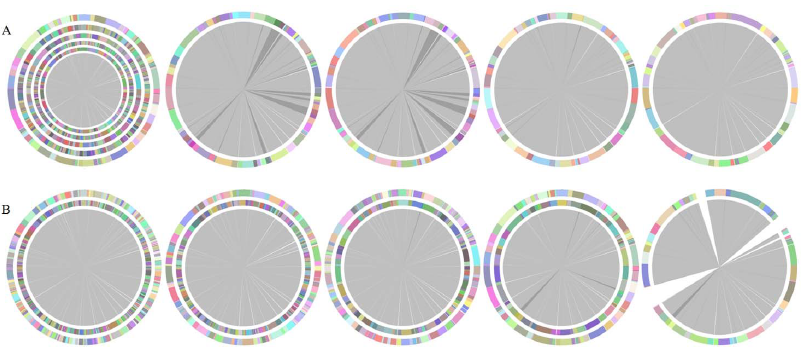
Figure 2. Integration of five assemblies of 36 bp paired-end reads for E.coli using CISA and minimus2. (A) From left to right, CISA integrates the five assemblies (Abyss, CLC, Edena, SOAPdenovo and Velvet from the outer to the inner) and sequentially generates the processed contigs after phase (1), (2), (3), and (4). Each contig color is randomly assigned. The white and grey segments in the inner circle show missing and laying of contigs in the genome. The dark-grey segments represent overlaps between contigs. (B) From left to right, minimus2 firstly merges SOAPdenovo (the inner) with CLC (the outer), then merges the output (the inner) with Velvet (the outer) in the second run, merges the output (the inner) with Edena (the outer) in the third run, and finally merges the output (the inner) with Abyss (the outer) in the fourth run to generate a hybrid assembly.